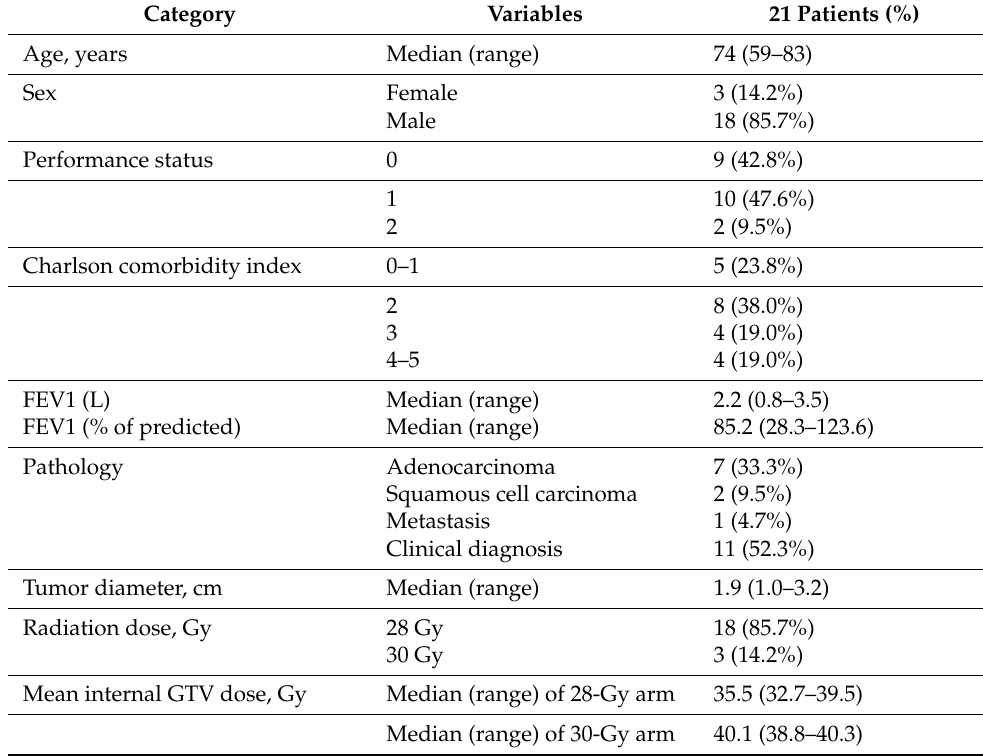
Table 1. Patient